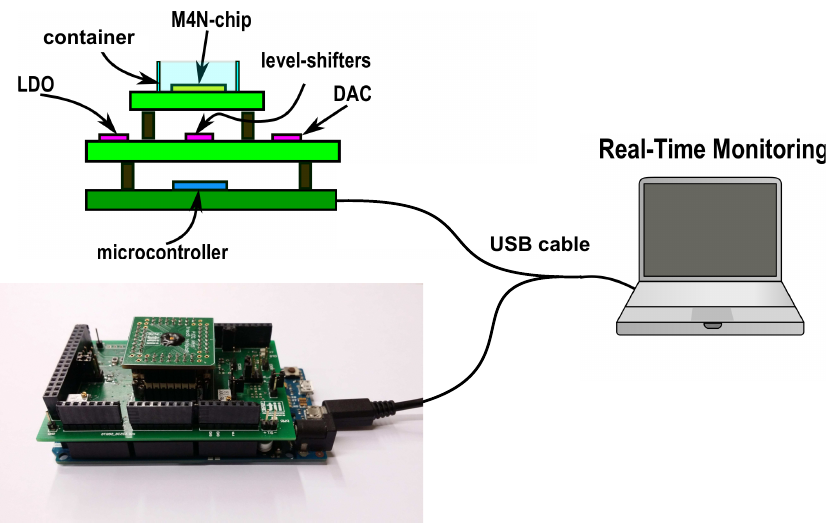
Figure 6. Entire sensing system consisting in three modules: the M4N chip ( Top ), an interface board ( Middle ) and the microcontroller platform ( Bottom ), which is directly connected to a notebook for data storage. Under the sketch, a photograph of the fabricated M4N